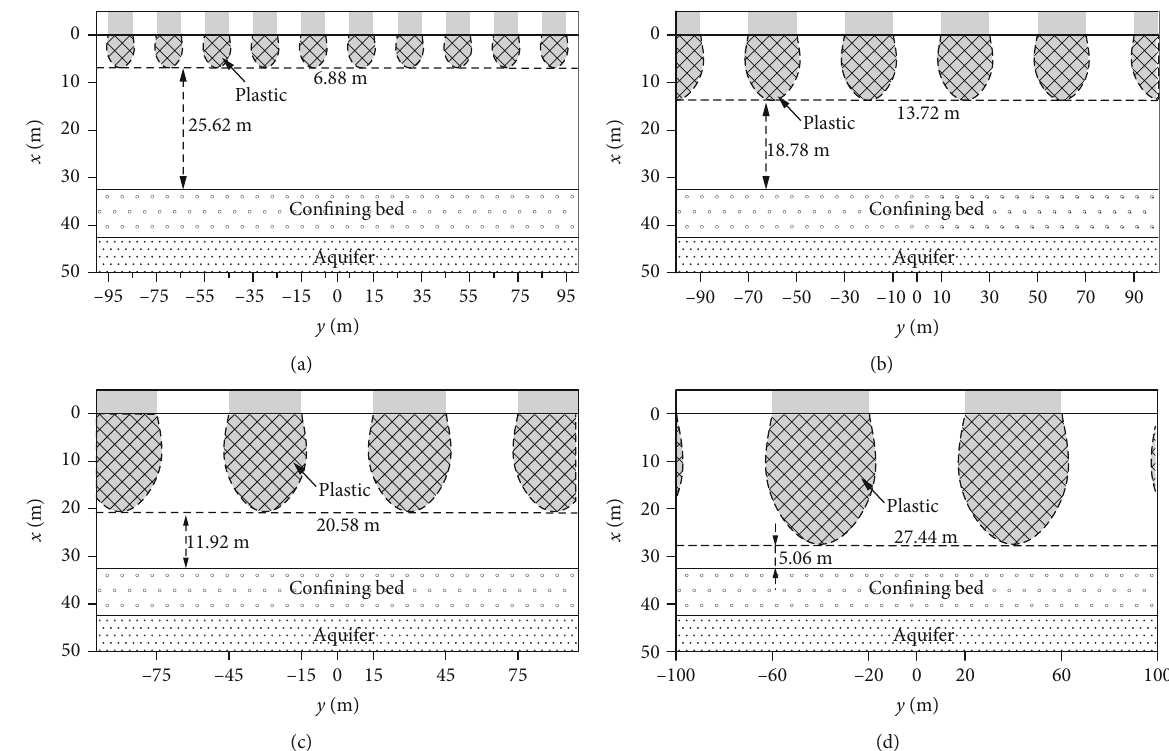
Figure 10: Floor failure area distribution patterns: (a) width of excavated coal pillar is 10m, (b) width of excavated coal pillar is 20 m, (c) width of excavated coal pillar is 30 m, and (d) width of excavated coal pillar is